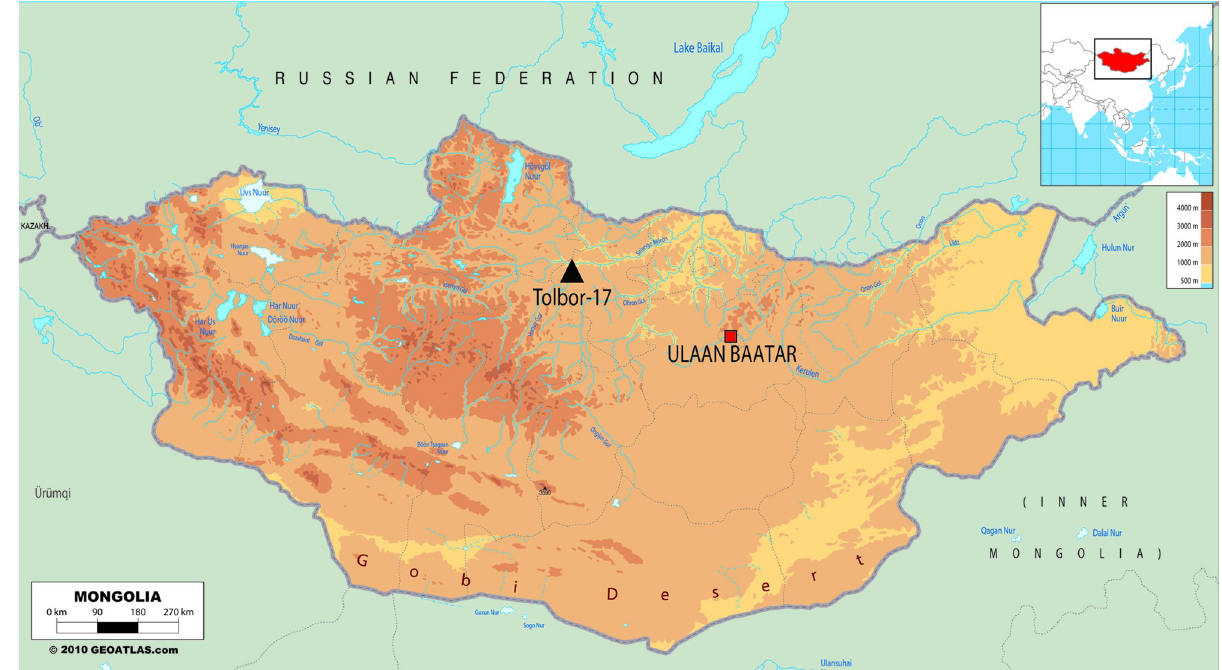
Fig 1. Map of Mongolia with geographic position of Tolbor-17. Map modified after Geo-atlas.